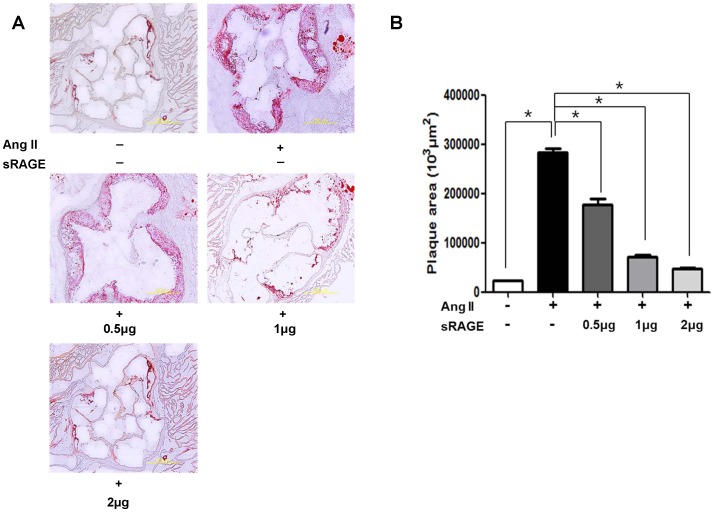
Quantification of Atherosclerosis.A. Photomicrographs of atherosclerotic lesions from aortic sinuses of Apo E KO saline injection mice, AngII infused, and AngII infused with various doses of sRAGE (n = 7); scale bar, 200 µm. B. Quantitative data, *p<0.01.